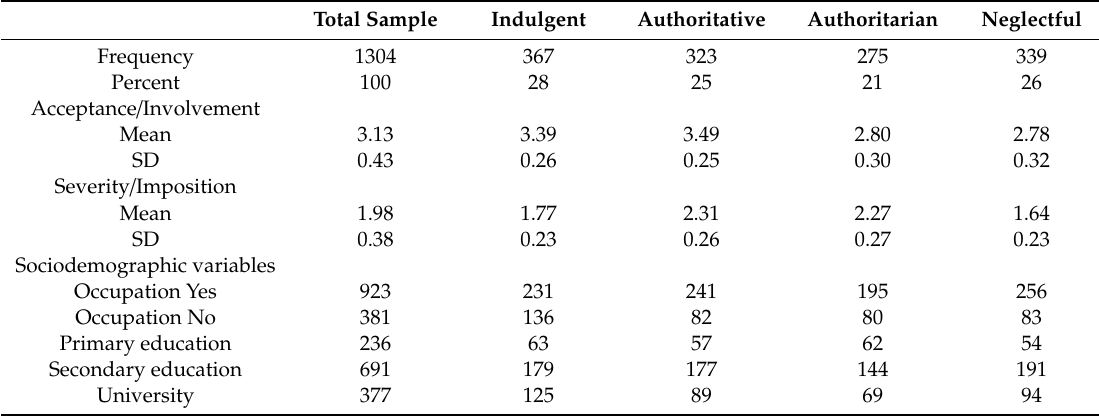
Table 1. Numbers of cases in parenting style groups, as well as mean scores and standard deviations on measures of parental